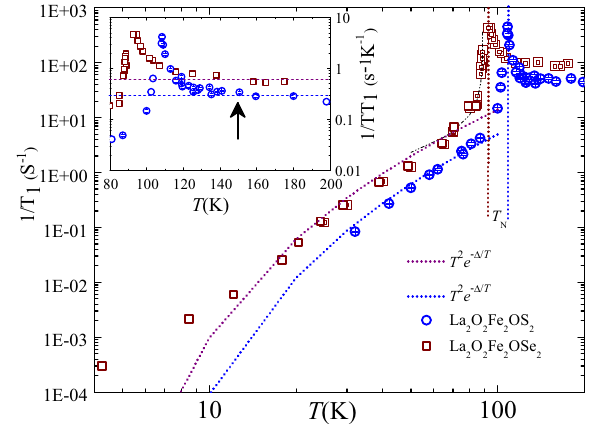
Fig. 5 The 139 La fi eld sweep NMR spectra taken at 30 MHz. In general, for a nuclear spin ( I = 7/2), in a lower symmetry system such as orthorhombic and tetragonal, for the presence of fi nite EFG at the La site, there are seven peaks due to the selective transitions between the levels ( m , m − 1, where m = 7/2, 5/2, ... and − 5/2). For T > T N typical non-magnetic I = 7/2 powder spectra are observed. Arrows indicate the corresponding satellite transitions. Black solid lines are simulated spectra. Green and red solid lines at 100, 50, and 20 K represent calculated sub spectra due to magnetically none- quivalent sites. The vertical line indicates the fi eld at which 139 (1/ T 1 ) were measured.